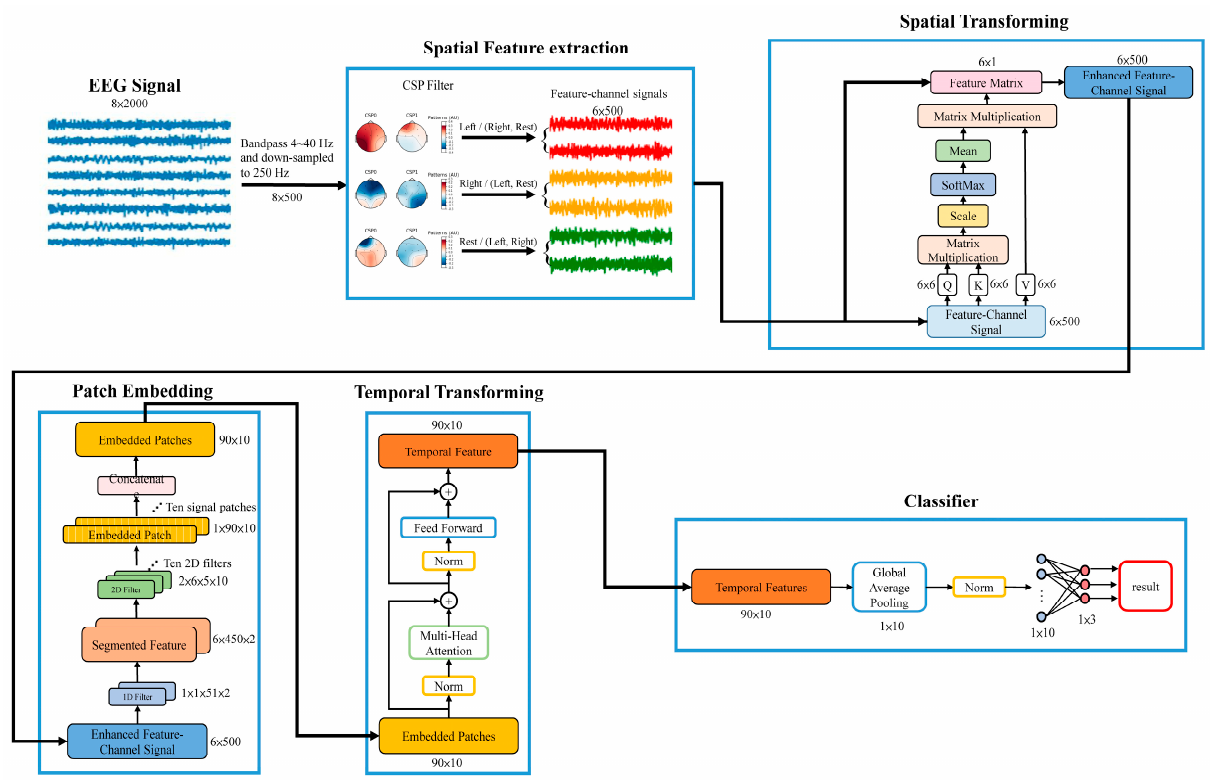
Figure 3. The architecture of the TSTN network. The EEG signals were prefiltered within 4~40 Hz and then downsampled to 250 Hz. The feature-channel signals were extracted using CSP, and then further enhanced by means of applying spatial transforming with an attention mechanism. The enhanced feature-channel data were segmented into ten embedded patches and the relationships among different temporal patches were perceived using multi-head transforming to obtain distinguishable representations.